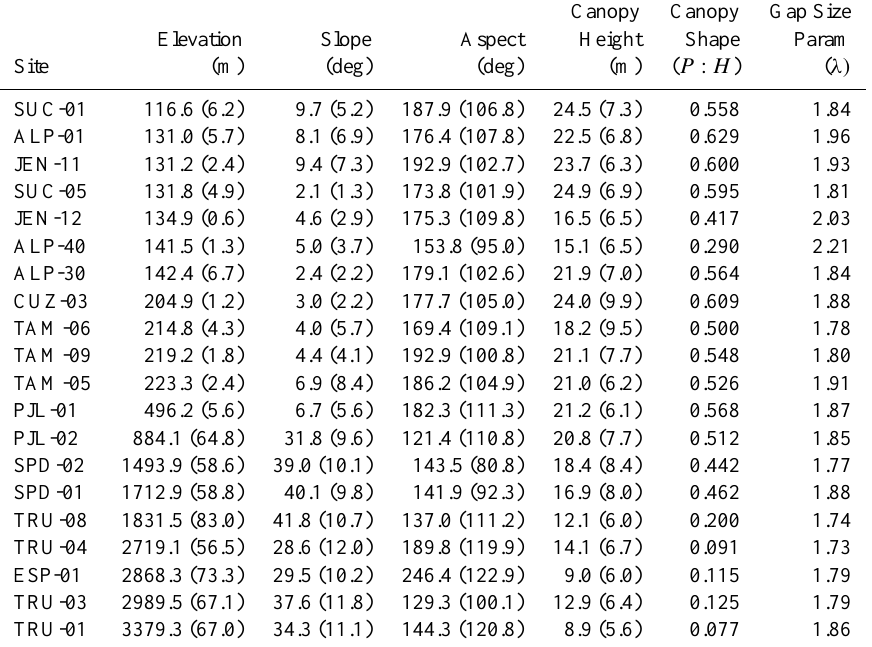
Table 2. Topographic variables for 25ha Andes-to-Amazon landscapes measured with the CAO lidar. Mean values for ground elevation, slope, aspect, and canopy height are provided with standard deviations in parentheses. The canopy shape ratio is the height of peak canopy volume ( P ) divided by the 99th percentile total canopy height ( H ). The canopy gap size parameter ( λ) is the negative slope of the power-law relationship between gap size and frequency. Canopy